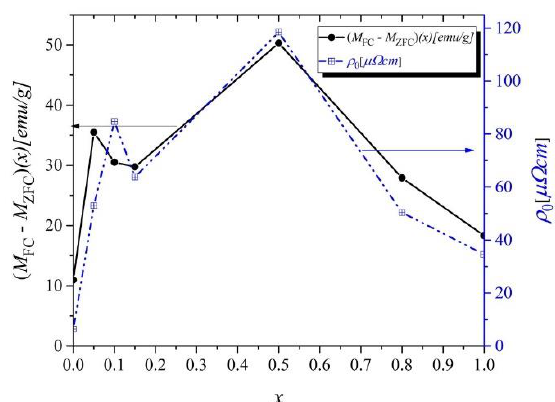
Figure 3. Difference between the M FC and M ZFC values at 2 K (left axis). Residual resistivity ( ρ 0 ) vs. concentration x , discussed in Section 2.4 (right axis).